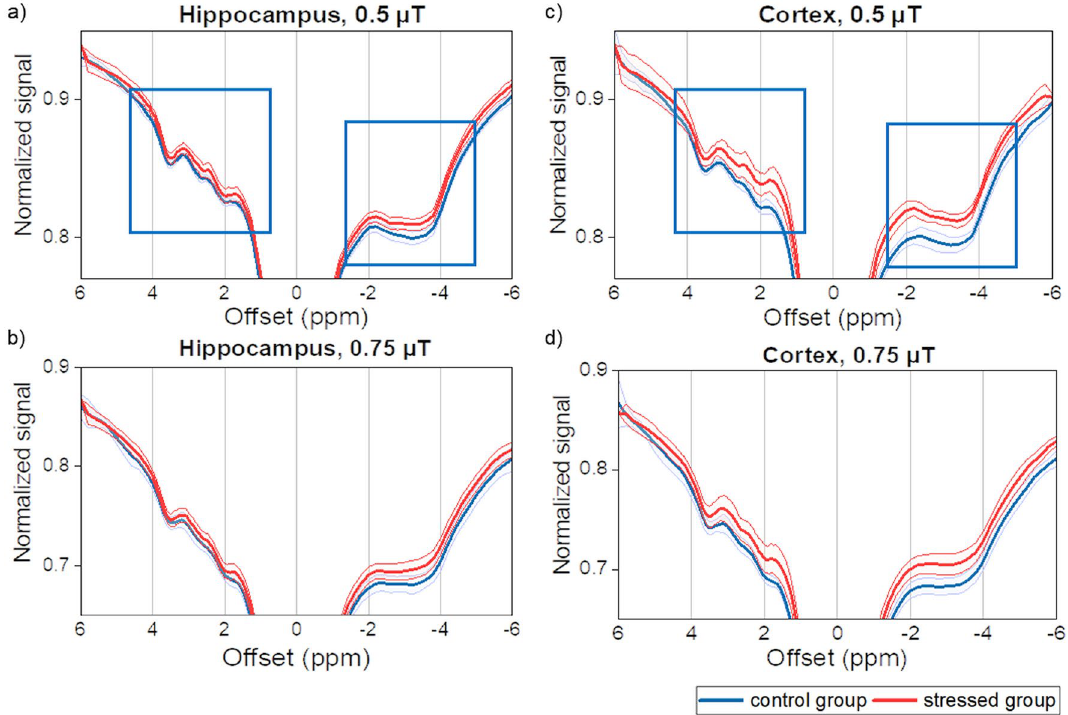
Figure 2. Mean Z-spectra from the ( a , b ) hippocampus and ( c , d ) cortex acquired with saturation B 1 s of 0.5 and 0.75 µT show a lowering of CEST contrast (an increase in signal) after stress, mainly in the cortex. The ranges with the largest differences are marked with blue rectangles. The solid lines are the average Z-spectra for all the animals in the group, whereas the shaded areas illustrate one standard deviation.